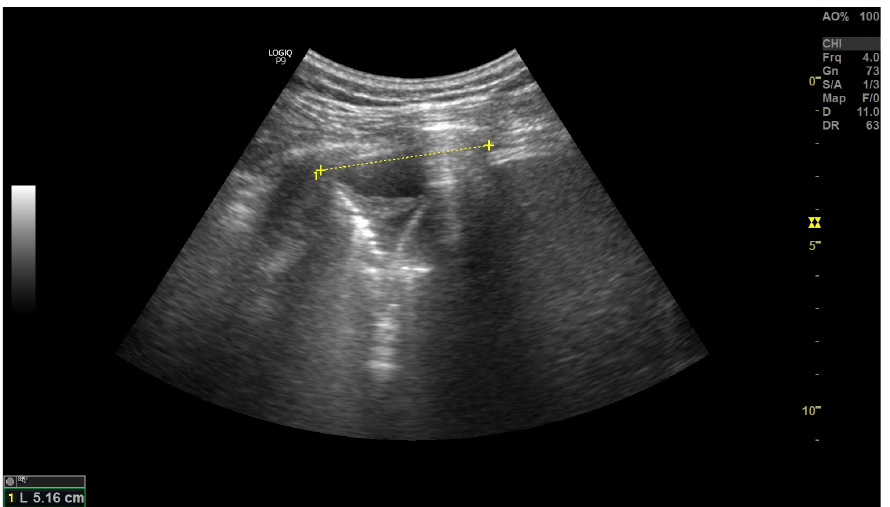
Figure 7. A very small amount of deeply hypoechoic free fluid in the costophrenic recess. Height of the fluid collection is measured. A small area of compression atelectasis. Figure were acquired in the Department of Internal Medicine, Pulmonary Diseases and Allergy, Medical University of Warsaw.